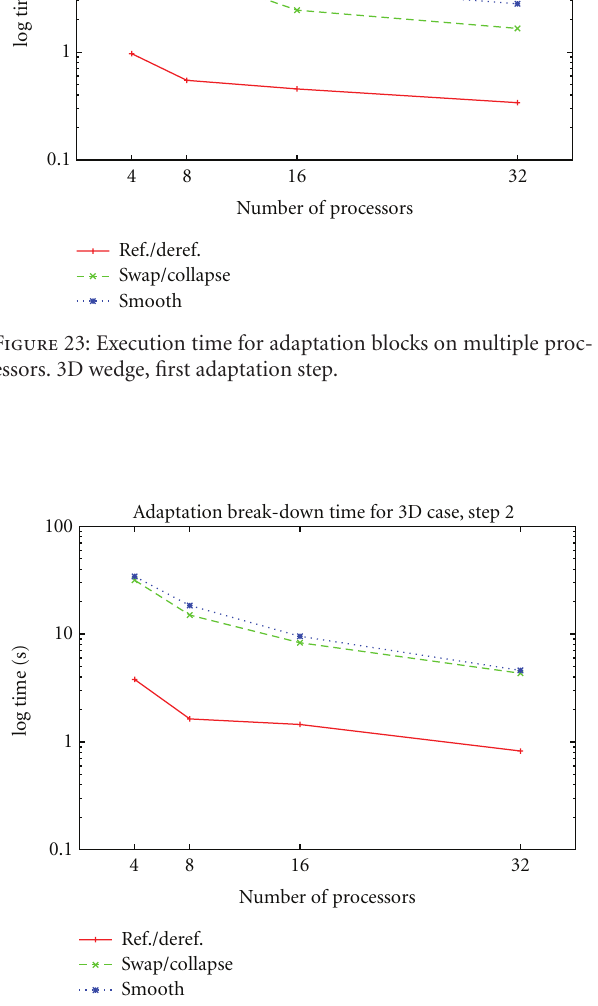
Figure 24: Execution time for adaptation blocks on multiple proc- essors. 3D wedge, second adaptation step.